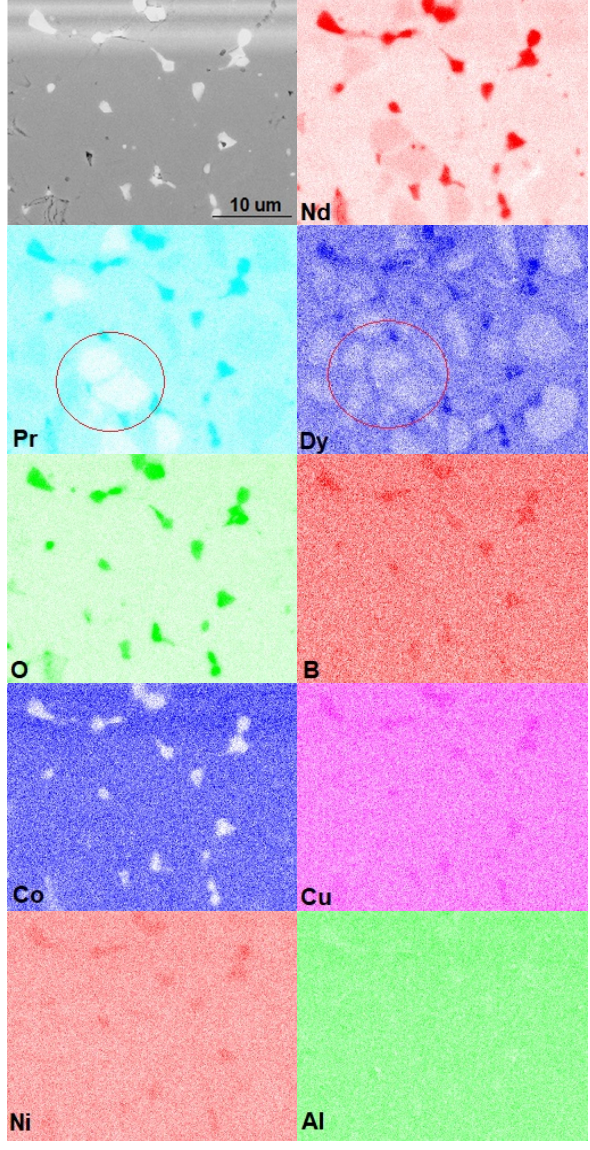
Figure 4. SEM image and elemental mapping of Nd, Pr, Dy, O, B, Co, Cu, Ni and Al. The formation mechanism of the core-shell structure in the magnets prepared from the powder mixture containing Nd 2 Fe 14 BH x , (Nd,Pr,Dy) 2 Fe 14 BH x , Nd, NdH x and small amounts of Dy and DyH x